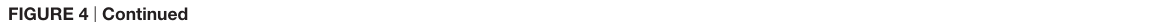
was assessed by q-PCR. Error bars represent the standard error of the mean from three experiments each repeated in duplicate ( n = 3). (c) DU145 were seeded in 24 well plates (0.0110 6 per well) in 5 mM glucose-containing GM for 24 h and then changed to either 5 or 25 mM glucose-containing SFM for 48 h, followed by dosing with either 100 ng/ml of IGF-II or insulin for another 72 h. Proliferative activity was detected by TTI assay. Error bars represents the SE of the mean from five experiments each repeated in triplicate ( n = 5). (D) DU145 cells were seeded into culture-inserts in 6 well plates in 5 mM GM. After 24 h, cells were treated with